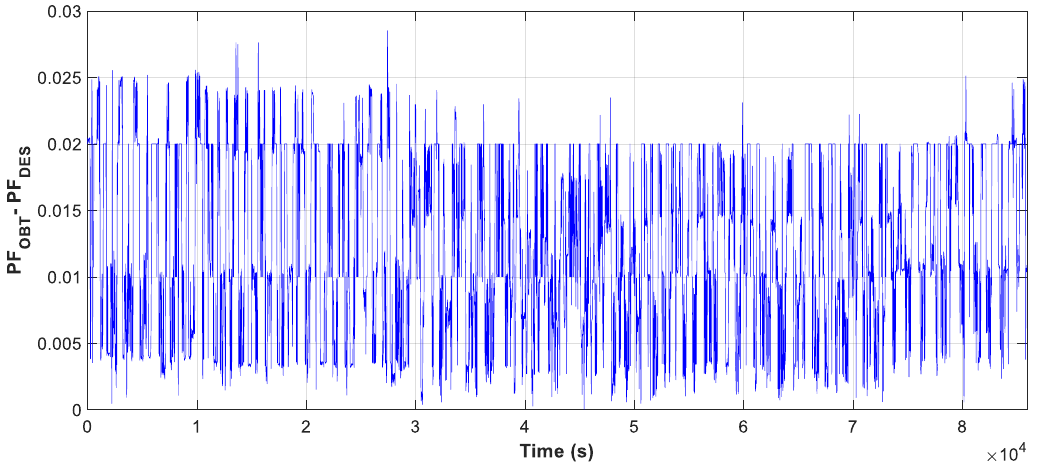
ff erence between PF Figure 22. Difference between PF OBT and PF DES of daily. Figure 22. Di